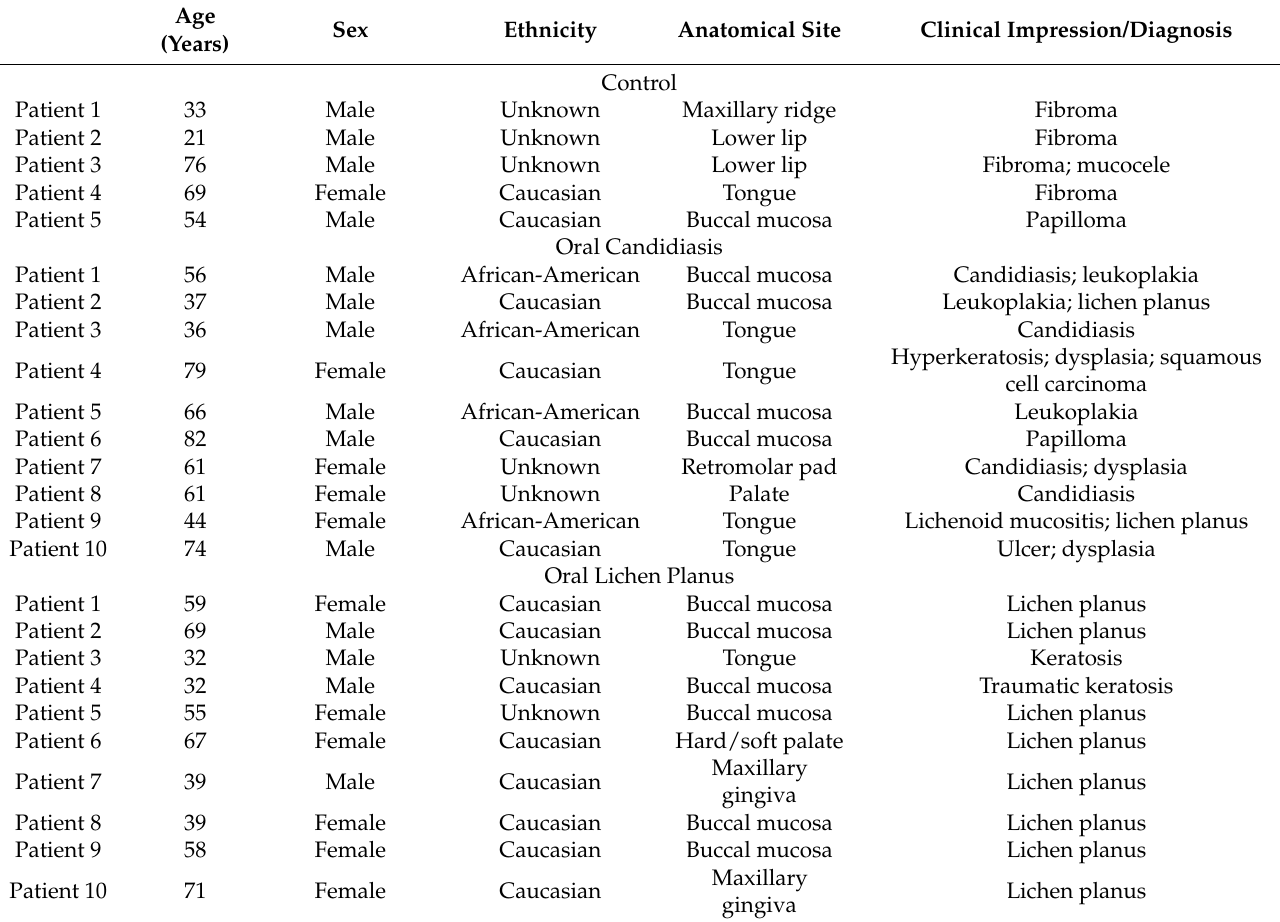
Table 1. Features of experimental subjects whose biopsy samples were used for this study. Accord- ingly, age, sex, ethnicity (if known), and anatomical site of lesions are included, as well as clinical impression/diagnosis prior to biopsy for histopathological